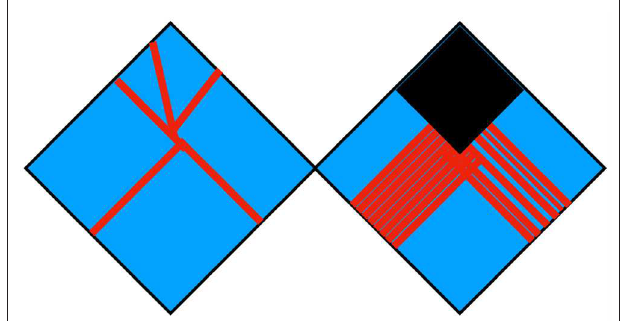
FIGURE 1 | The left figure shows a system with a number of constraints much smaller than the total number of degrees of freedom while the right one is what happens when the constrained subspace has entropy that is an order one fraction of the total. Red lines denote jet degrees of freedom, each of which is surrounded on the past/future boundary of the diamond, by frozen degrees of freedom,indicated by erasure of the boundary. The diamonds in these figures are finite, and the right hand picture does not include black hole